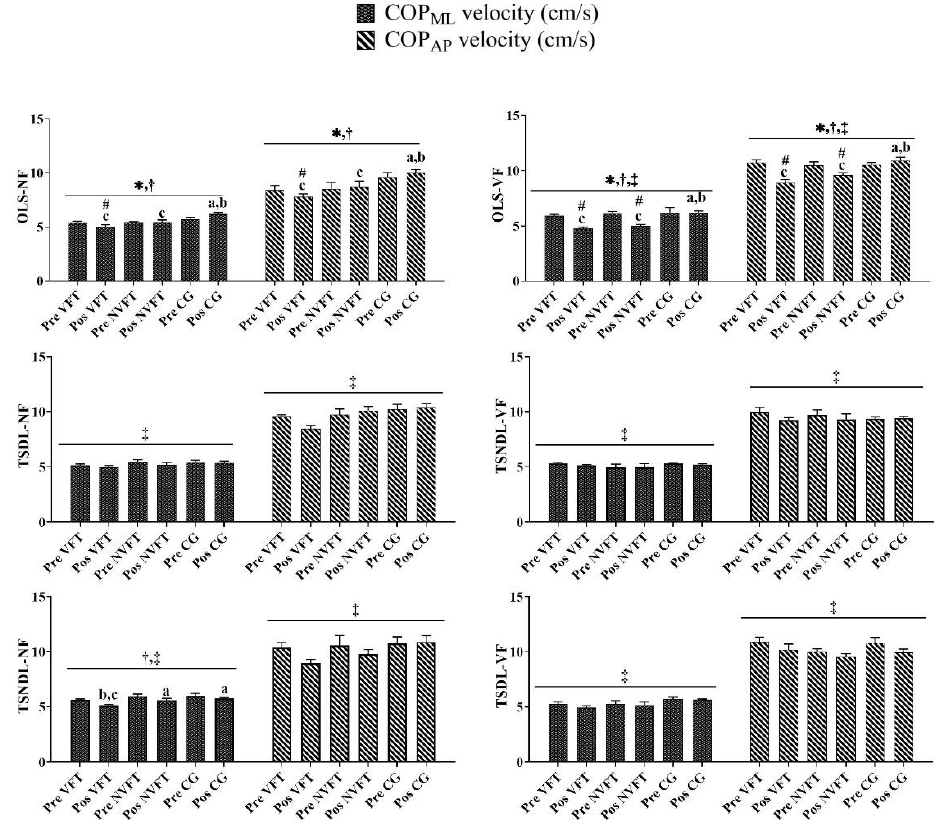
Figure 3. The training of group and time differences in the COP ML and COP AP velocity parameters. Note: * Indicates a significant difference in interaction (Group*Times) ( p < 0.05). † Indicates a significant difference in main effect (group) ( p < 0.05). ‡ Indicates a significant difference in main effect (times) ( p < 0.05). # Indicates a significant difference with pre-test. a Indicates a significant difference with VFT. b Indicates a significant difference with NVFT. c Indicates a significant difference with CG. VFT and NVFT before and after the test of various parameters of COP in OLS/TS. There was a significant difference in the interaction (Group*Times) of the COP ML velocity or COP AP velocity in OLS ( p < 0.05). There was no significant difference in the interaction (Group*Times) of the COP ML velocity or COP AP velocity in TS ( p > 0.05).